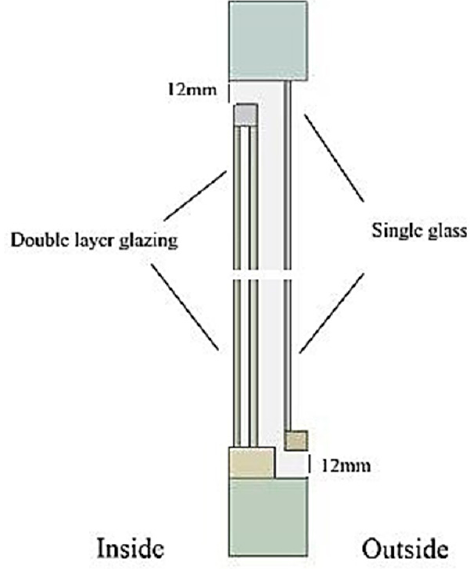
Figure 5. Schematic illustration of the ventilated